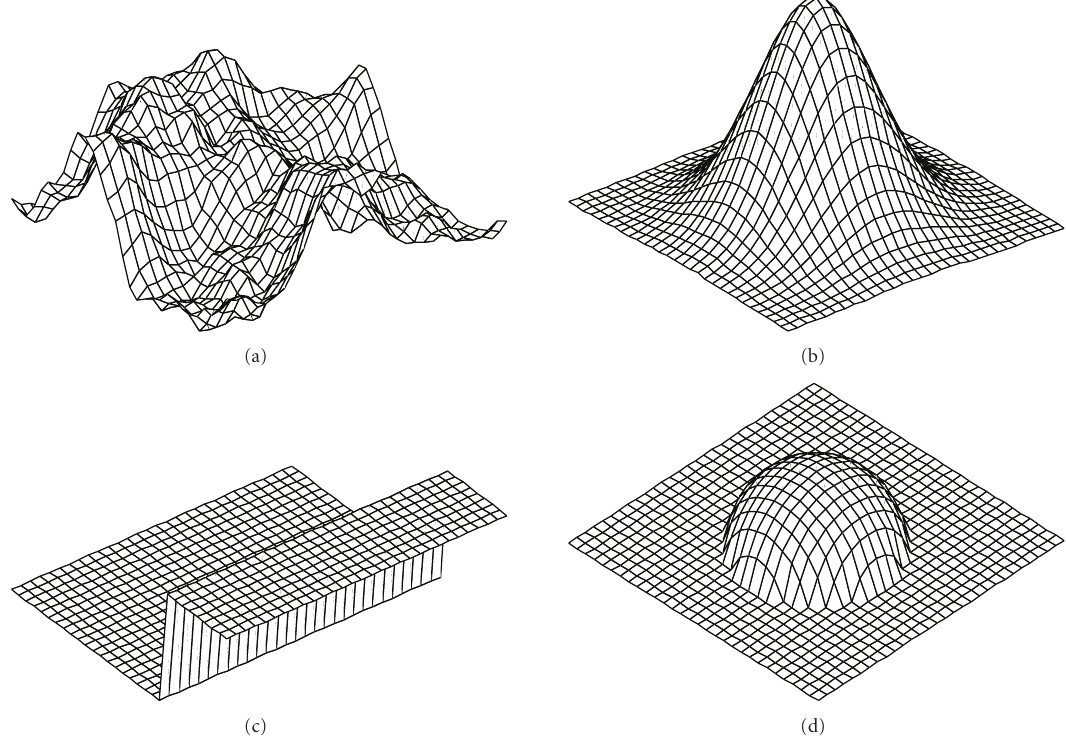
Figure 5: Examples of height maps terminals ff tGen , gauss , step , and sphere .